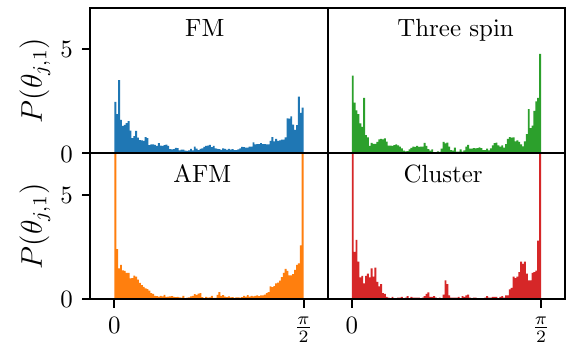
FIG. 8. Distribution of angles θ j ,1 associated with the Hamil- tonian in Eq. (11) in the QAOA evolution across phase diagrams of FM, AFM, three-spin, and cluster Ising models in Eqs. (10), (A1) and (B1). Data are for system size N = 8 with the exception of N = 9 for the three-spin Ising model. In all the plots, p = 4.